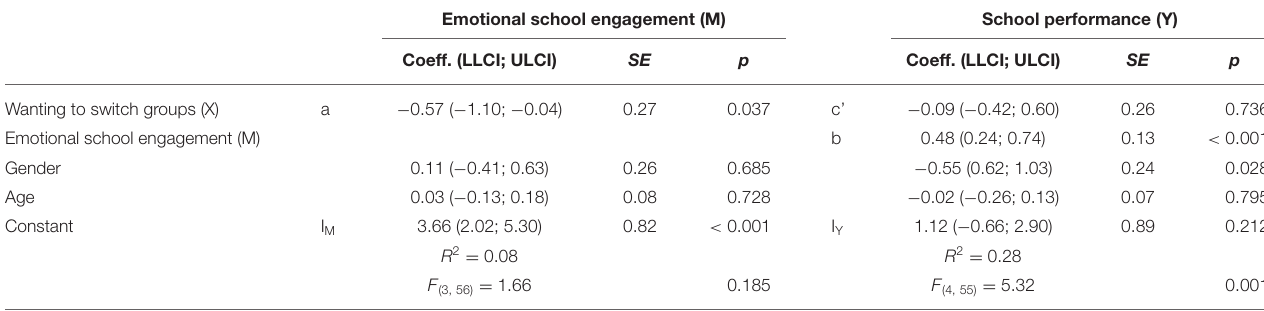
TABLE 3 | Mediation model for the relationship of wanting to switch groups and school performance via emotional school engagement ( n = 60). Emotional school engagement (M) School performance (Y) Coeff. (LLCI;